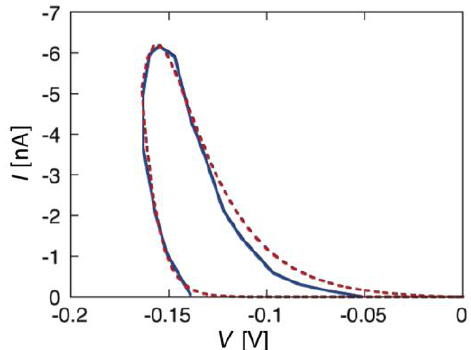
Figure 4. Experimental I-V curve for 0.2 μg/mL alamethicin in bacterial phosphatidylethanolamine, taken from curve 2 in Figure 5 of Vodyanoy et al. [46] (blue curve) and curve calculated for a = 1 × 10 −2 , ∆ m = 70 D, θ 0 = 0.1, k N k R 2 = 1 × 10 5 s −3 and n = 1 (red curve). The height of the calculated curve was normalized to that of the experimental one. (Reprinted with permission from [38] . Copyright 2015, Elsevier).